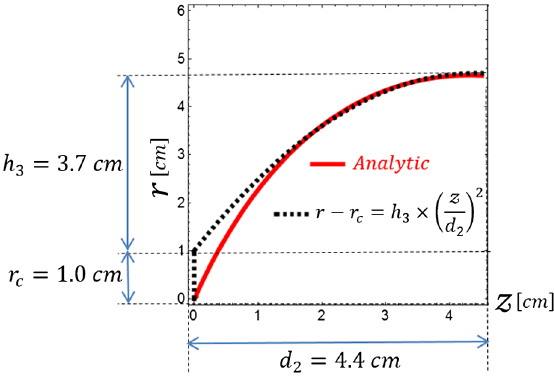
FIG. 5. Geometry of zero equipotential surface (the cathode plus the focusing electrode surfaces) in comparison with a